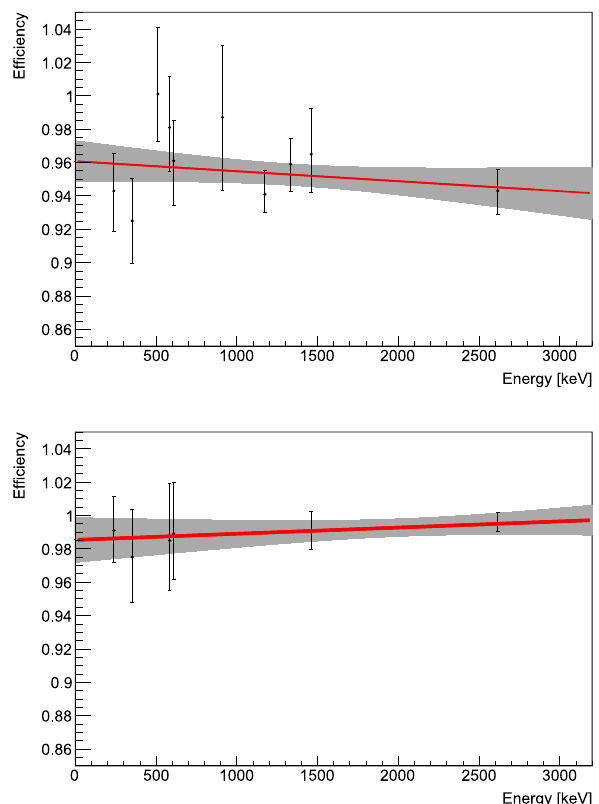
Fig. 9 PlotshowingtheefficiencyforthePCAcut(upper)andnormal- ized light distance cut (lower) obtained from M 1 γ peaks as a function of the peak energy (back points). We fit these graphs to a linear poly- nomial (red line) and the confidence interval of this linear fit is shown in gray